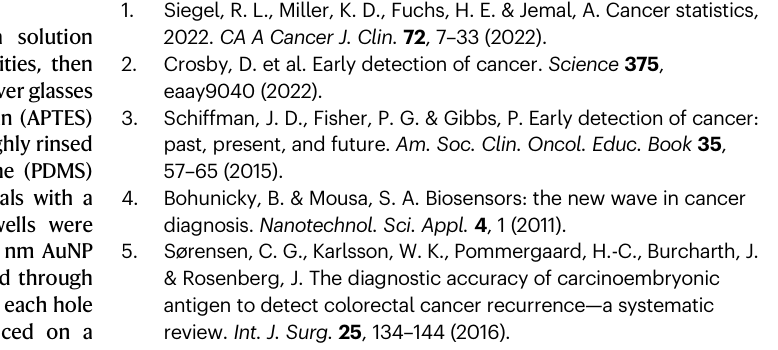
calnexinantibodieswereusedatadilutionof1:1000.Anti-ApoA,ApoB, and HSA antibodies were used at a dilution of 1:3000. The membranes incubated with the diluted primary antibodies in 2% BSA solution for overnight at 4 °C. The membranes were then incubated with HRP- labeled secondary antibodies, goat anti-mouse IgG for exosomal pro- teins and HSA, and goat anti-rabbit IgG for lipoproteins (CELLNEST, South Korea) at dilutions of 1:10,000 and developed by chemilumi- nescence substrate (Bio-Rad, USA). The signals were captured using the bio-imaging system(Amersham ImageQuant 800, cytiva, Germany).